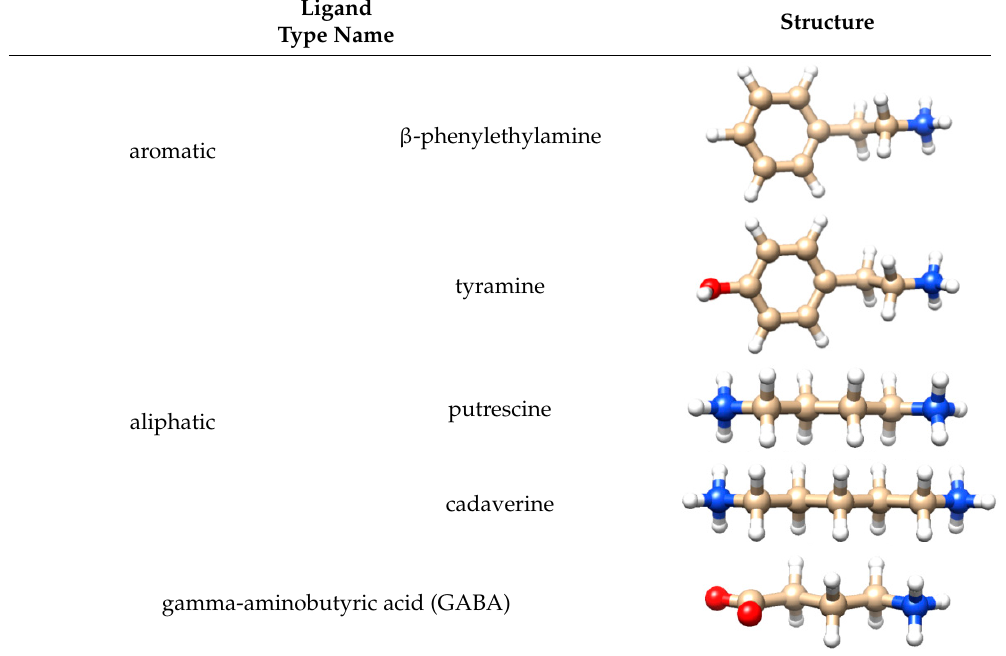
Table 7. Structures of ligands for docking with TAAR1 and TAAR6 receptors.